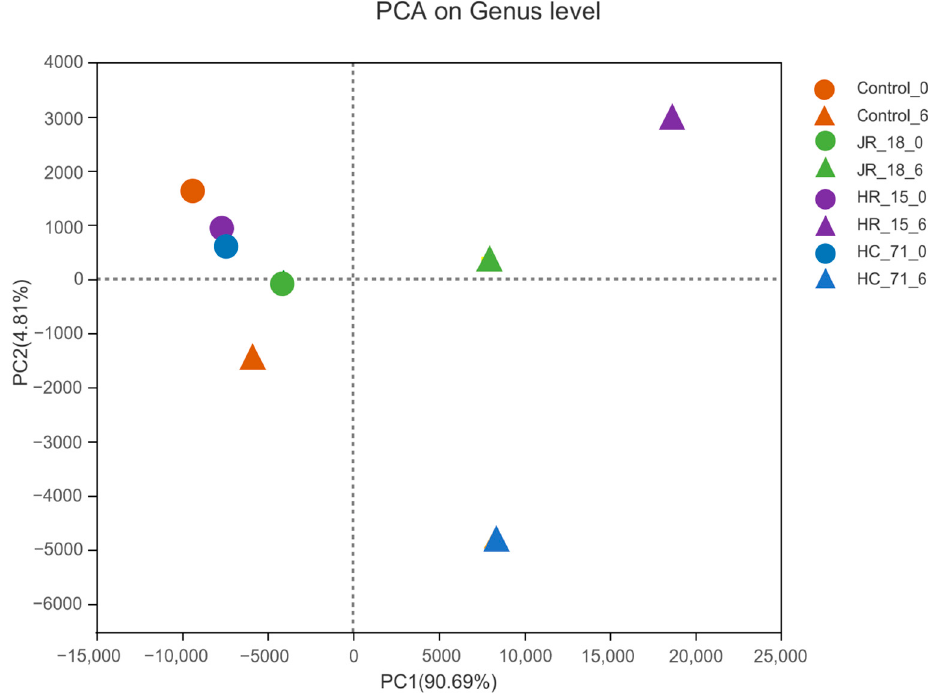
Figure 5. The principal component analysis on the genus level of the intestinal flora of tilapia inoculated with different S . putrefaciens strains (HR-15, JR-18, and HC-71).